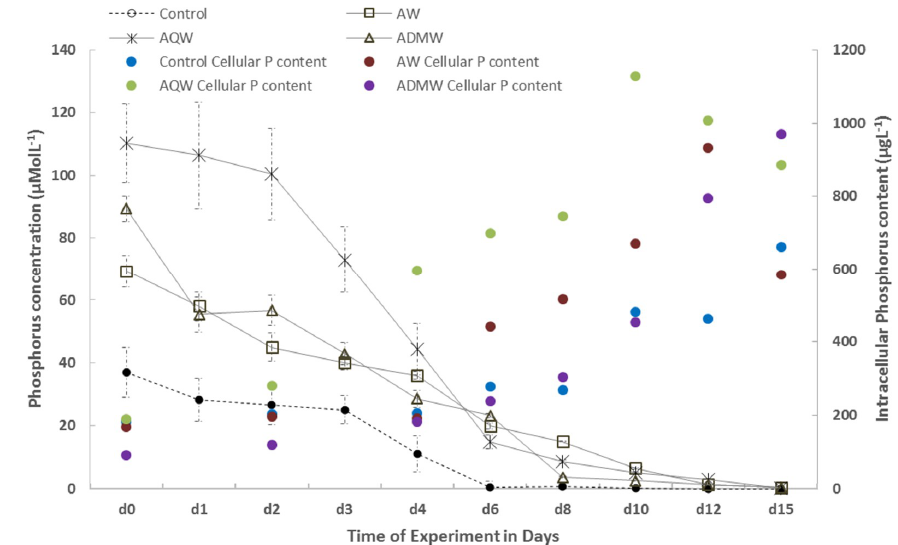
Figure 5. Phosphorus uptake (in µMol L −1 ); lines with markers) and intracellular phosphorus content of N. oceanica (in µg L −1 ; scatter) for Control medium F/2; AW: Agricultural Waste; AQW: Aquaculture Waste; ADMW: Anaerobically Digested Municipal Waste. Error bars represent standard deviation for three biological replicates.